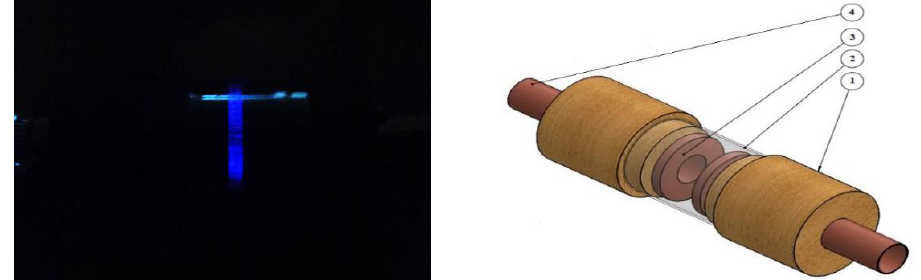
Figure 2. Photographic image and the 3D scheme of the AC-PPP reactor: (1) high voltage dielectric, (2) Pyrex tube, (3) copper disk, (4) copper pipe.